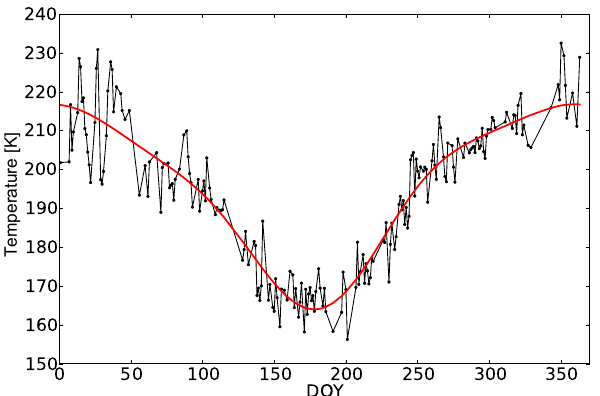
Figure 2. GRIPS-II nightly average temperatures of 2009 plotted at the day of year (DOY). The measurement data are shown in black and the harmonic fit using Eq. (1) is shown as the red curve.